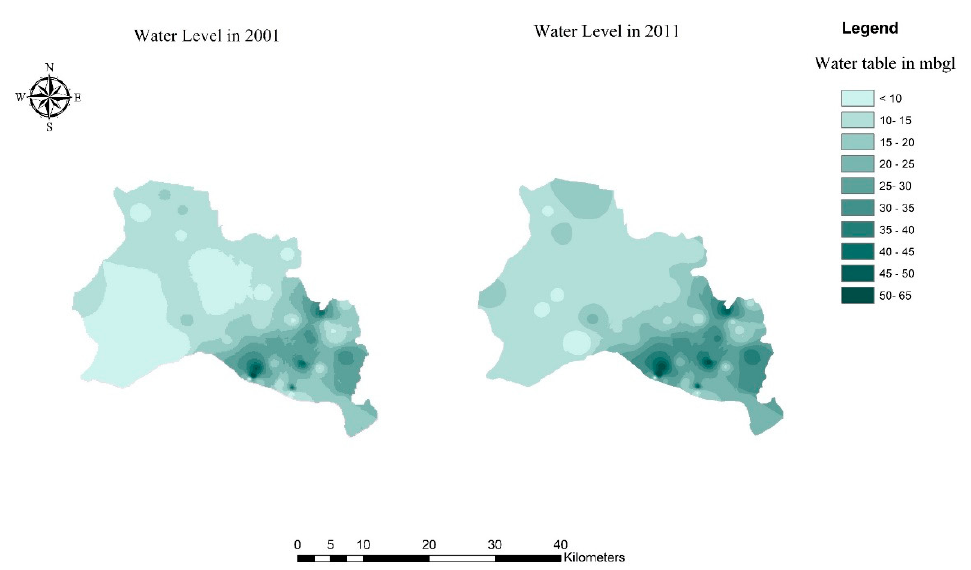
Figure 5. Spatio-temporal distribution of water level in year 2001 and 2011 in the study